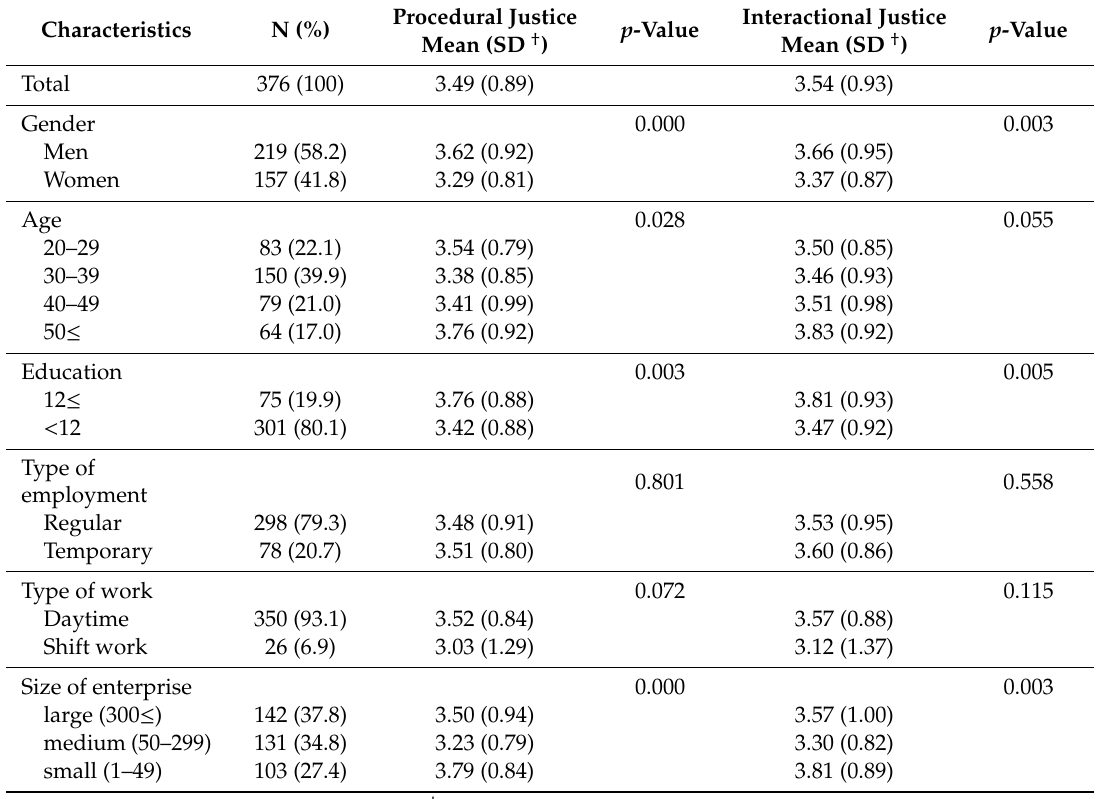
Table 1. Mean values of procedural justice and interactional justice by sociodemographic